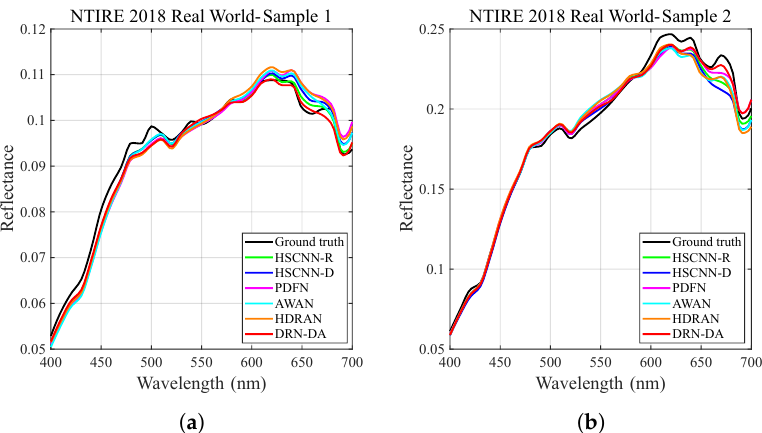
Figure 12. Spectral reflectance of selected samples from the NTIRE 2018 “Real World” track: ( a ) Sam- ple 1. ( b ) Sample 2.